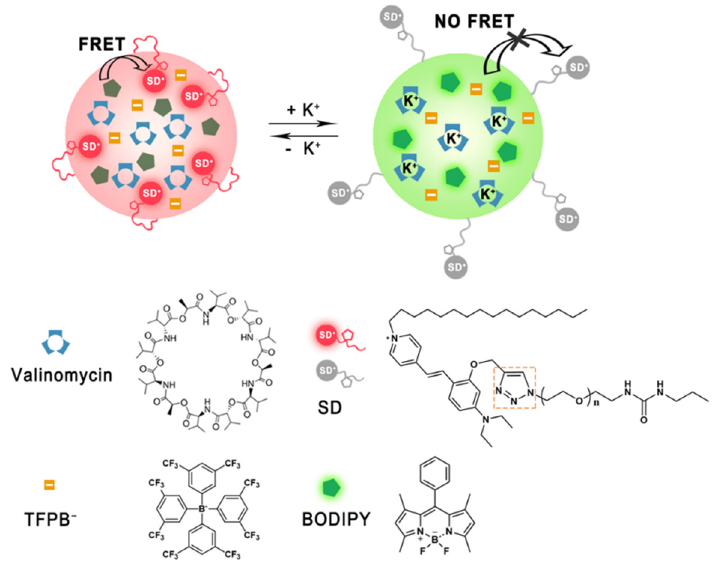
Figure 1. Schematic illustration of the K + selective nano-optodes containing the ionophore valinomycin, the ion exchanger TFPB − , and the covalently attached solvatochromic dye SD on the organosilica nanospheres. Fluorescence resonance energy transfer (FRET) is expected to occur between the reference dye BODIPY and SD. With increasing K + concentration, FRET becomes less likely due to the increased distance between BODIPY and SD.